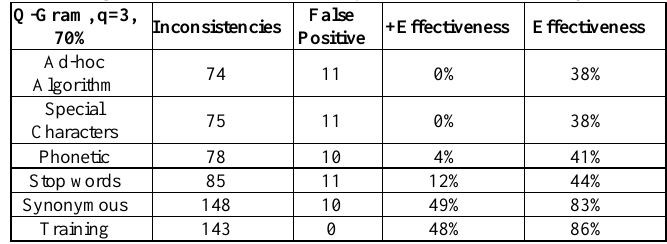
Table 6: Results obtained with data cleaning process using the algorithm Q-Grams, with q=3 and 70%